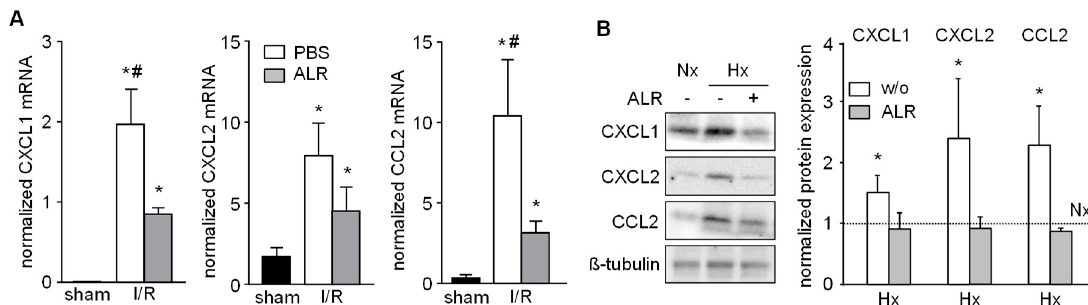
Figure 4. ALR attenuates hepatic chemokine expression in an IRI mouse model and in primary hepatocytes. ( A ) Liver tissues from IRI mice were analyzed for mRNA expression of chemo-attractants CXCL1 (Gro- α , KC), CXCL2 (Gro- β , MIP-2) and CCL2 (MCP-1) by qRT-PCR ( n = 6; gene expression was normalized to 18S). * p < 0.05 or # p < 0.05 di ff ers from sham or IR / ALR group, respectively. ( B ) Primary mouse hepatocytes were subjected to Nx or Hx in absence or presence of rALR (100 ng / mL). Protein expression of CXCL1, CXCL2 and CCL2 was analyzed by western blotting. Immunoblots from three di ff erent experiments were analyzed by densitometric analysis, normalized to Nx (dotted line); one representative is shown (for all data see Figure S3). * p < 0.05 di ff ers from Nx.